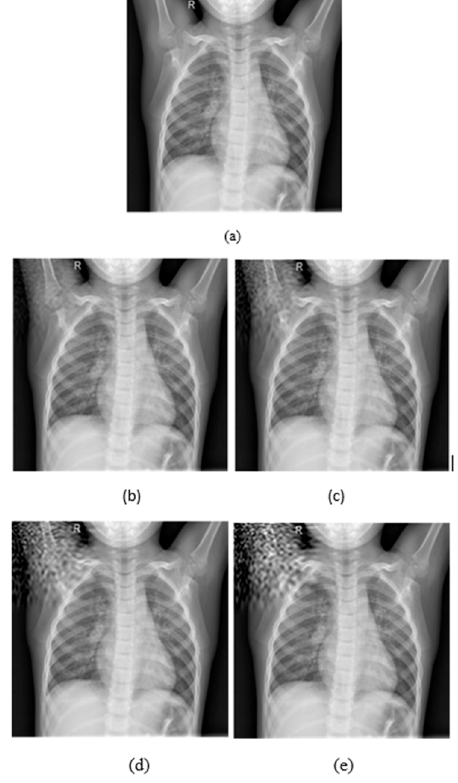
Figure 4. ( a ) Initial image. ( b ) Embedding strength = 50, ( c ) Embedding strength = 100, ( d ) Embedding strength = 200, ( e ) Embedding strength = 300. The rest of the parameters are L ‐ bit = 1000, p 1 = 0.1, p 2 = 0.1.